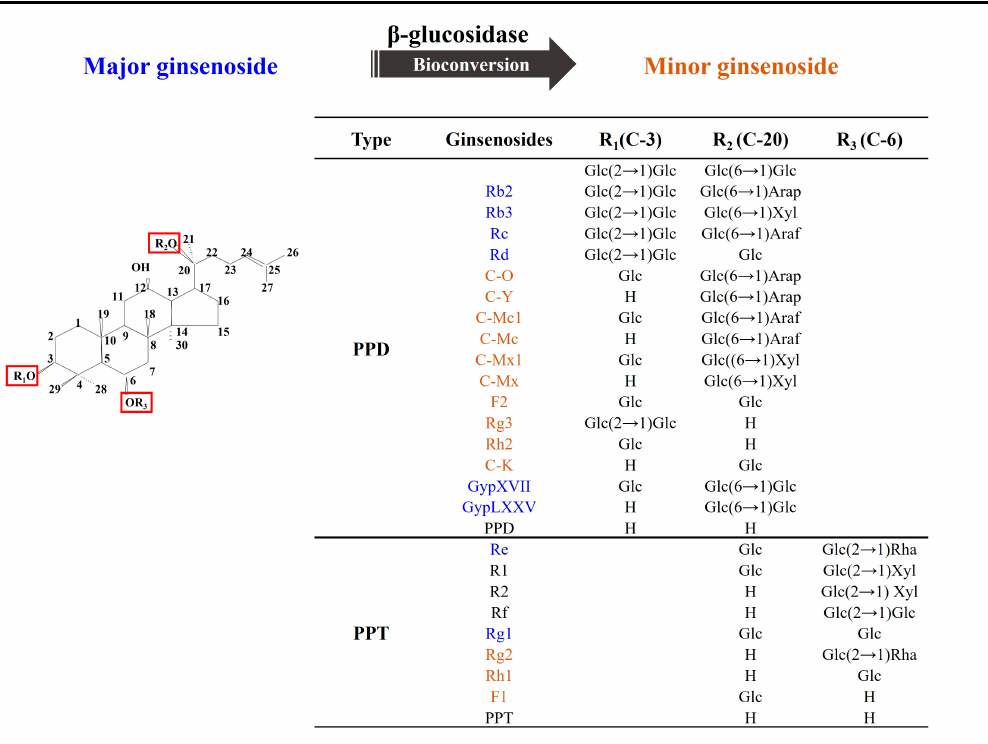
Figure 1. Different types of ginsenosides that may be candidates for bioconversion. Ginsenosides are discriminated by the type, number of sugar moieties, and the attracted position. The major and minor ginsenosides are marked in blue and orange, respectively. The abbreviation of sugar moieties are Glc: D-glucose, Arap: L-arabinopyranoside, Araf: L-arabinofuranoside; Xyl: D-xylose; Rha: L-rhamnose.